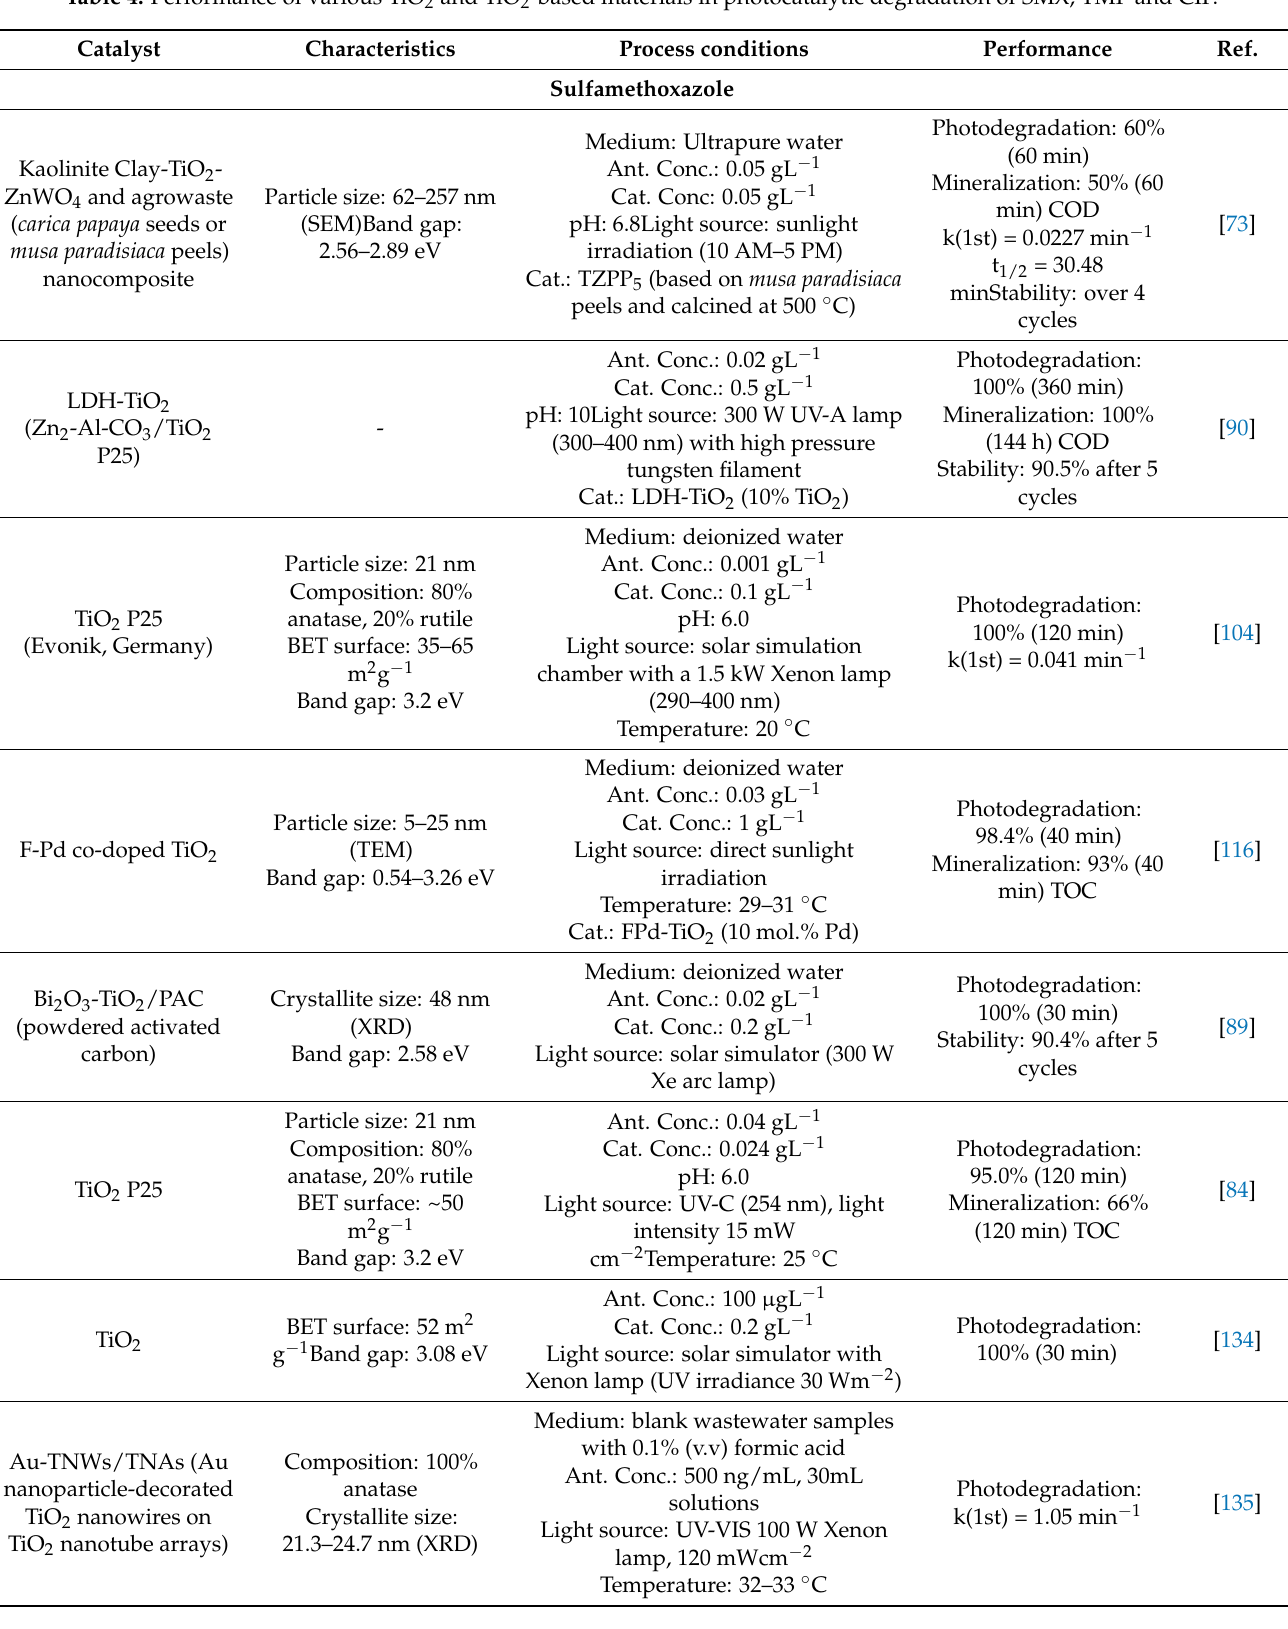
Table 4. Performance of various TiO 2 and TiO 2 -based materials in photocatalytic degradation of SMX, TMP and CIP.